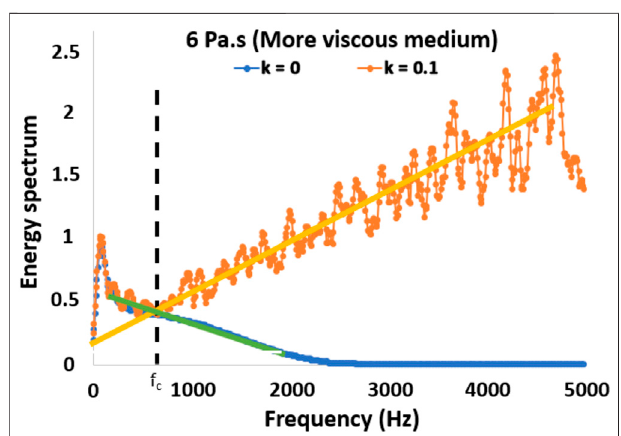
FIGURE 2 | Projected particle velocity spectrum of a viscoelastic solid with 6.0 Pa s viscosity and a k (cid:2) 0 . 1 noise level (orange curve). The green and yellow lines are linear fi ts to the noisy spectrum at low (0.1kHz – 0.5 kHz) and high frequencies (1 kHz – 5 kHz), respectively. The intersection of both fi ts allows determinationofthecutofffrequency f c .Thebluecurveshowsthenoise-freecase to demonstrate the agreement of the fi t over noisy data to the noiseless case.